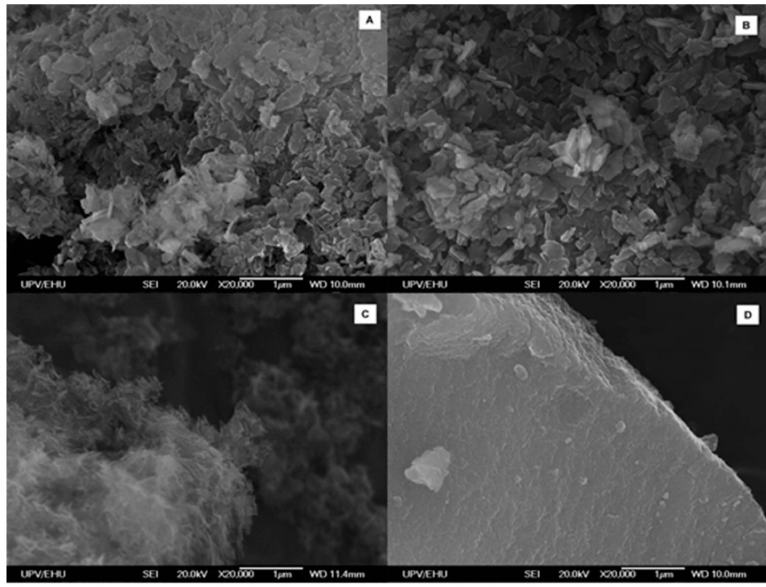
Figure 5. SEM images at 20 kX of aeroCo ( A ); xeroCo ( B ); aeroNi ( C ) and xeroNi ( D ).